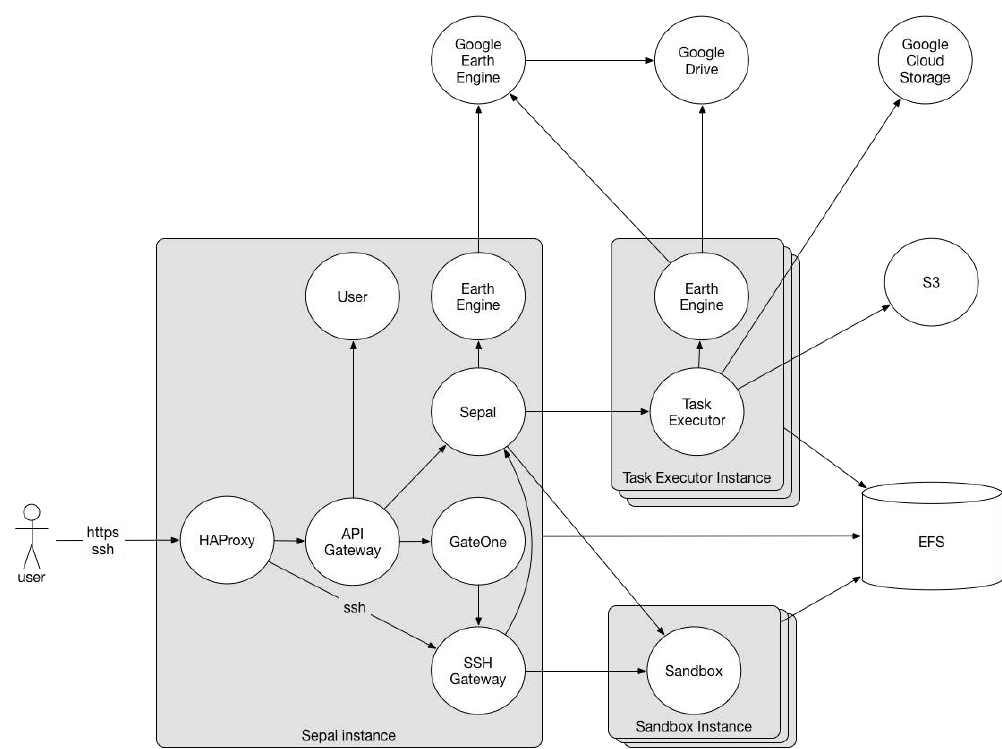
Figure 4. Architecture diagram of the System for Earth Observation Data Access, Processing and Analysis for Land Monitoring (SEPAL) platform. Source: FAO